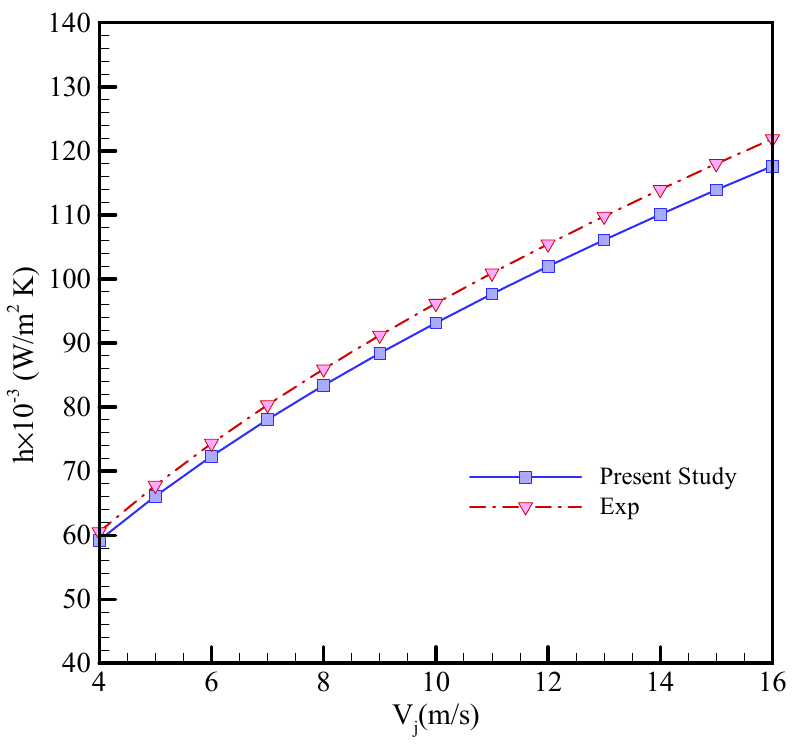
Figure 4. Numerical model validation by comparing with the results reported by [36] for water as coolant.